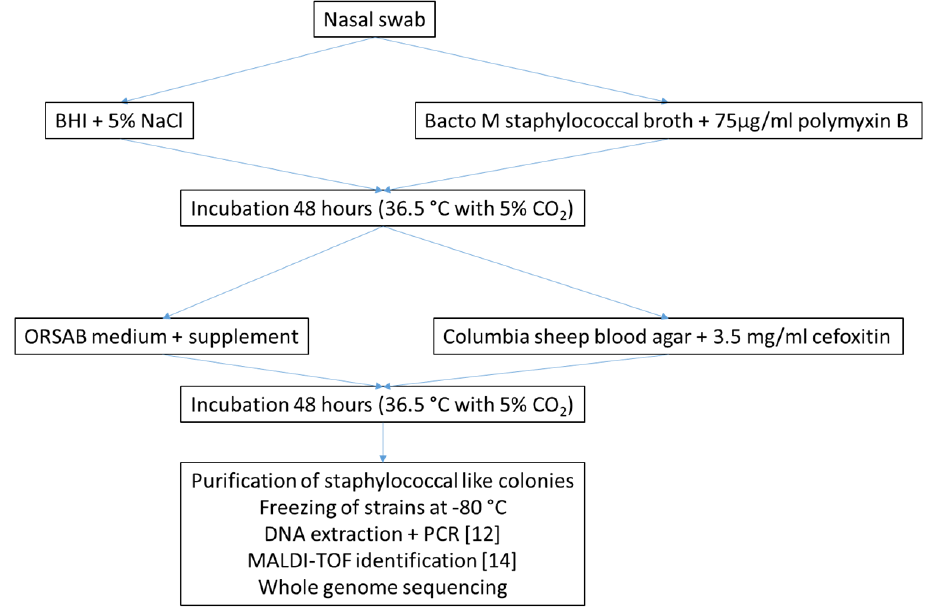
Figure 3. Isolation and identification